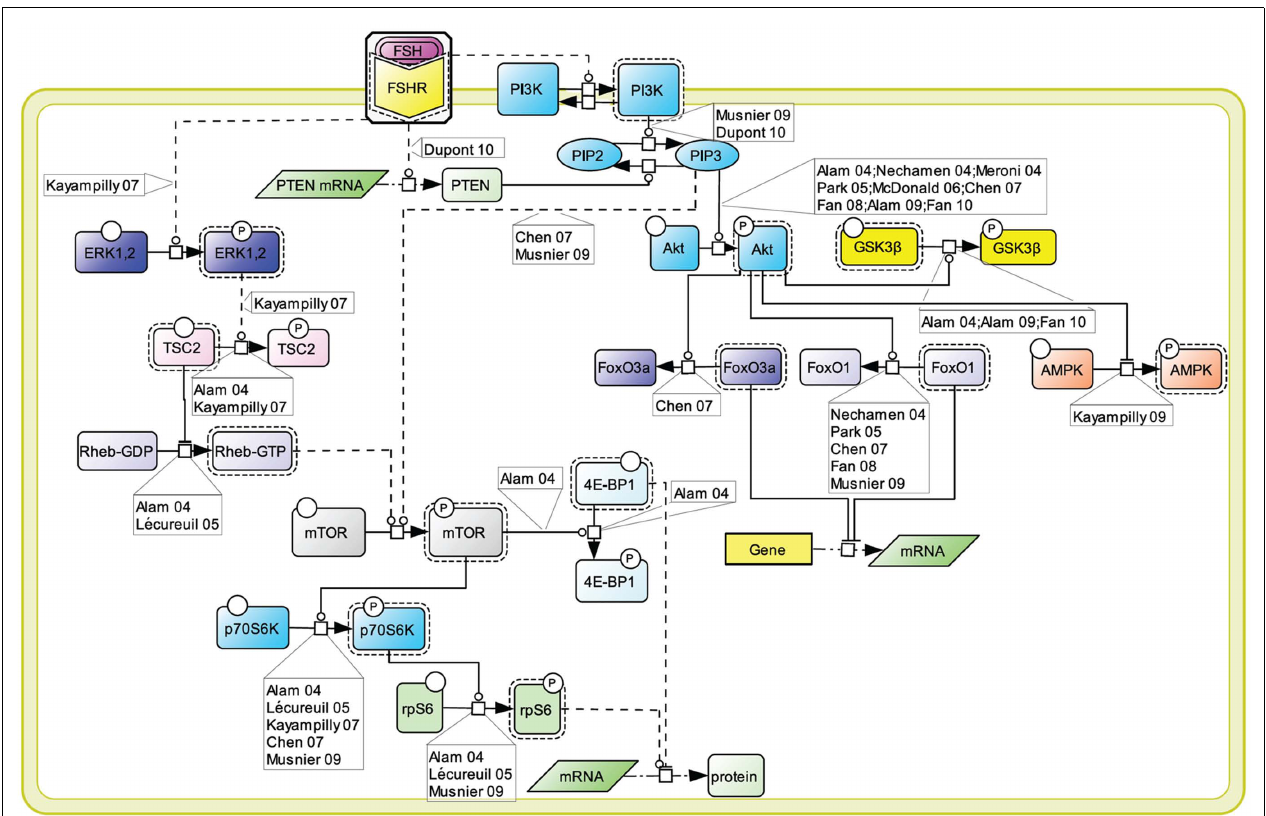
FIGURE 4 | PI3K/mTOR signaling at the FSHR. The PI3K/mTOR pathway plays an important role in FSH-induced actions, including proliferation, regulation of gene transcription as well as of protein